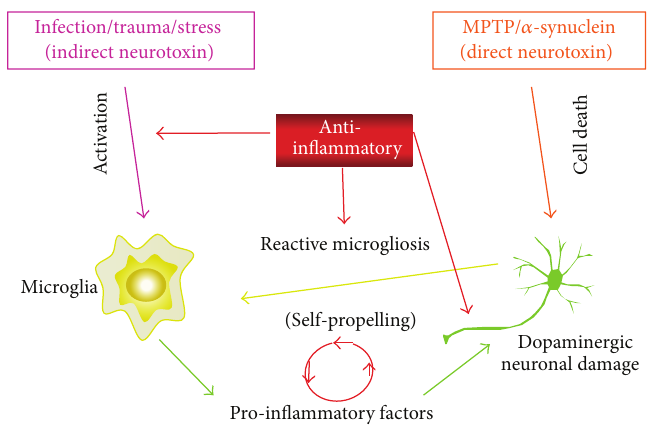
Figure 1: Model of neurodegeneration attributed to reactive microgliosis in Parkinson’s